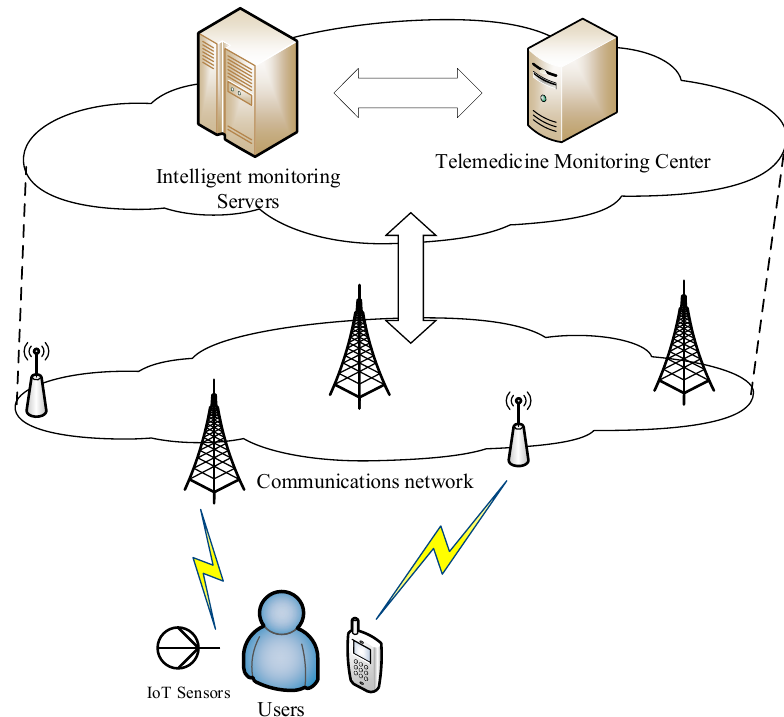
Figure 3. Actual application scenario of the biomedical signal monitoring framework.